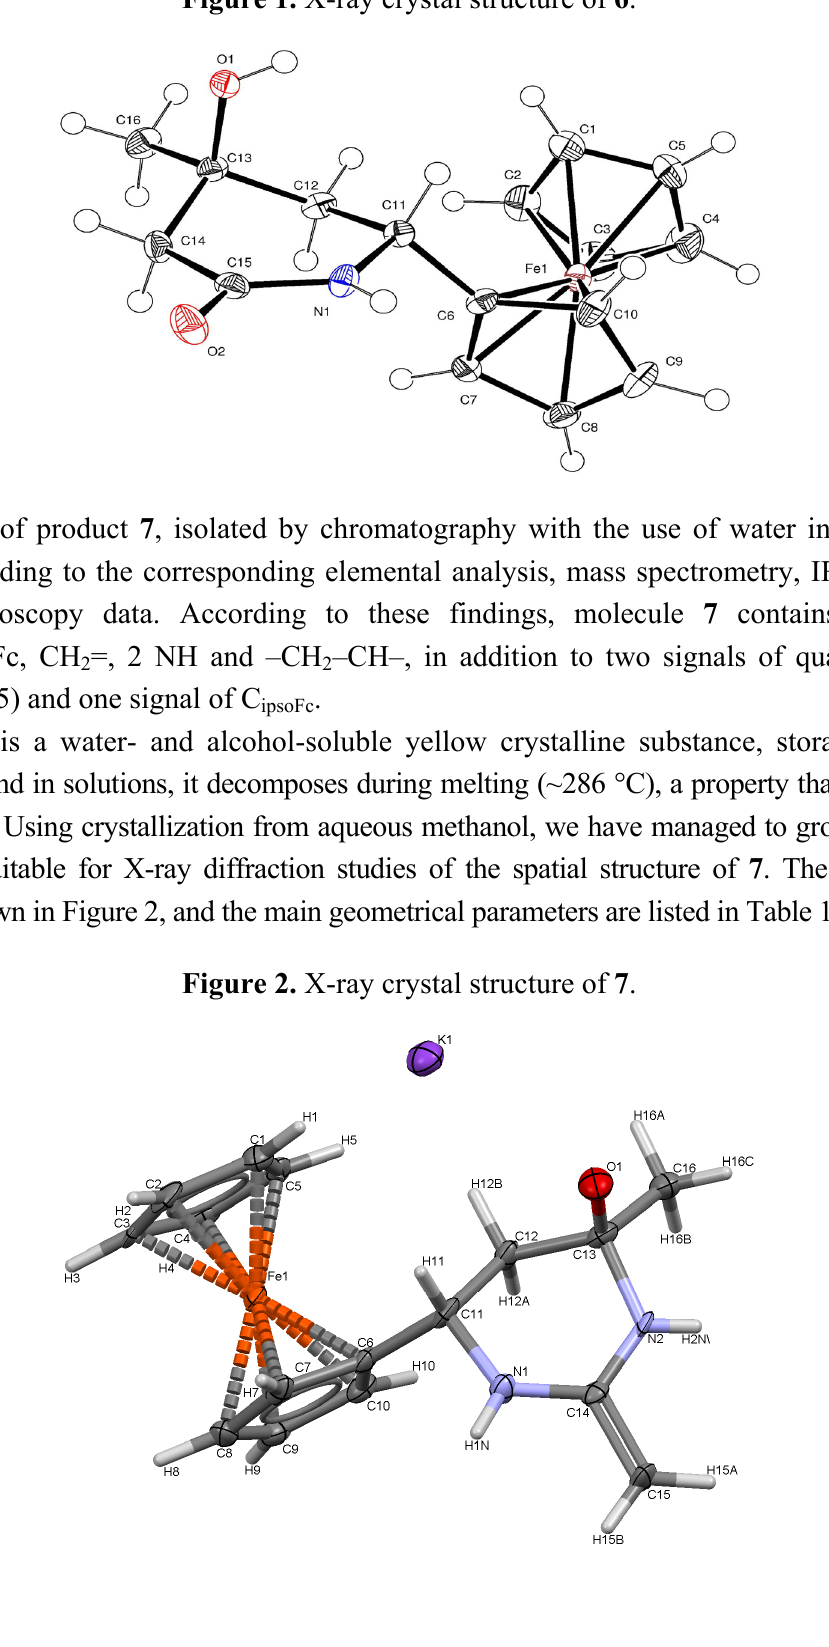
Figure 1. X-ray crystal structure of 6 .